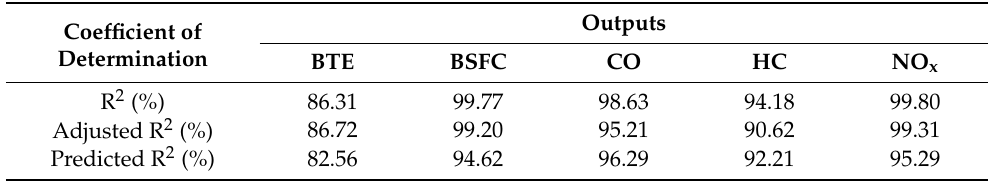
Table 7. Coefficient of determination (R 2 ) values of the mathematical